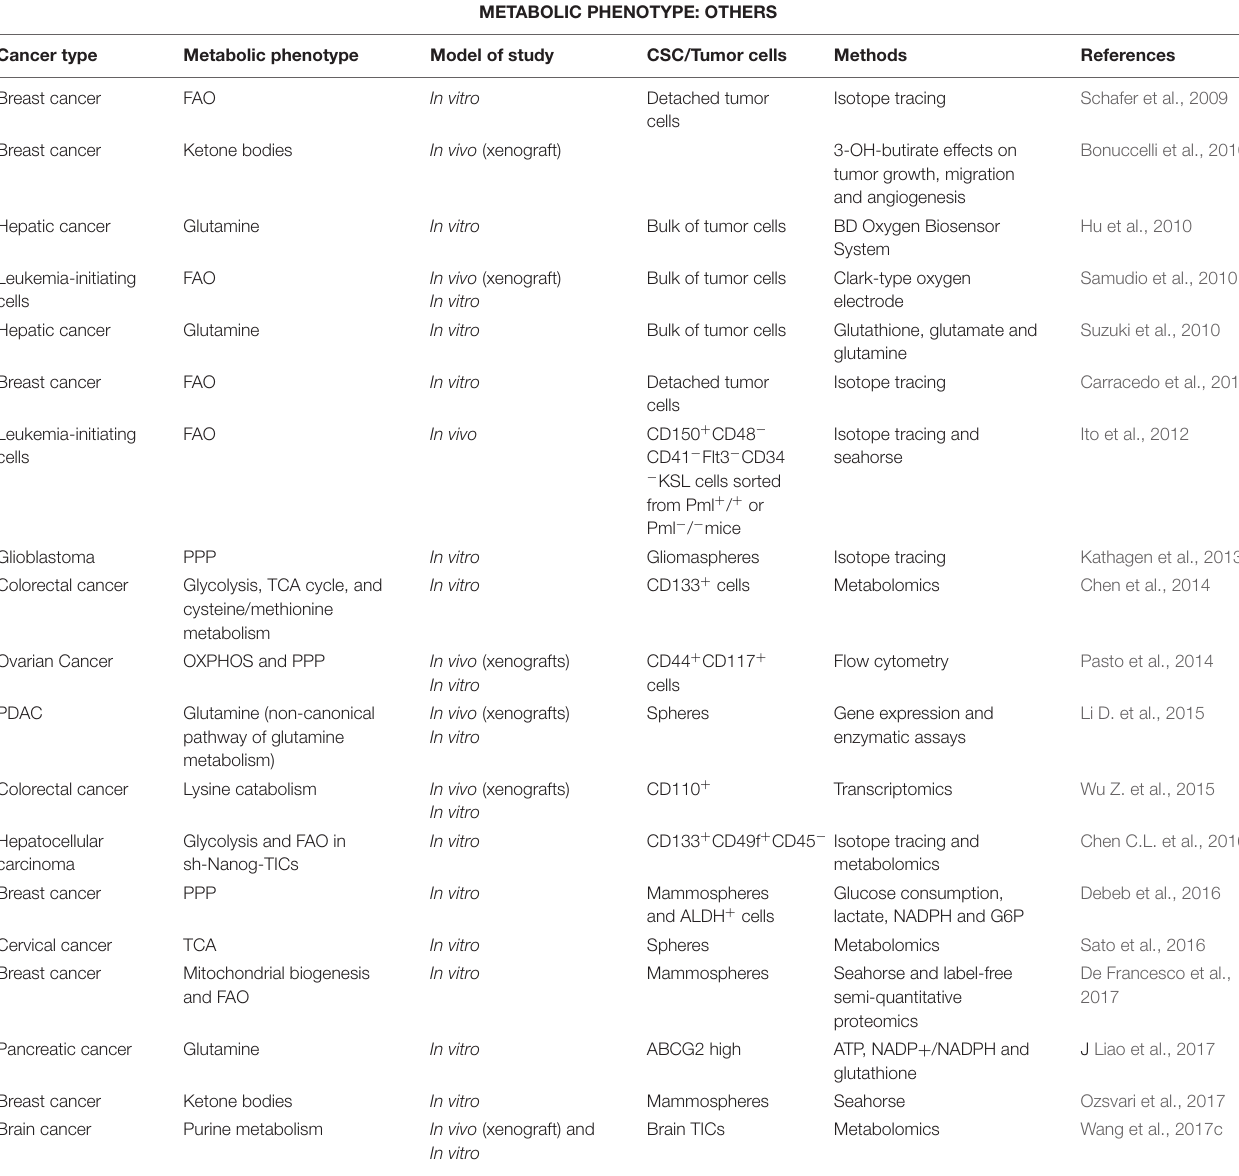
TABLE 3 | Stem-like cells using alternative metabolism for various cancer types (in chronological order). METABOLIC PHENOTYPE: